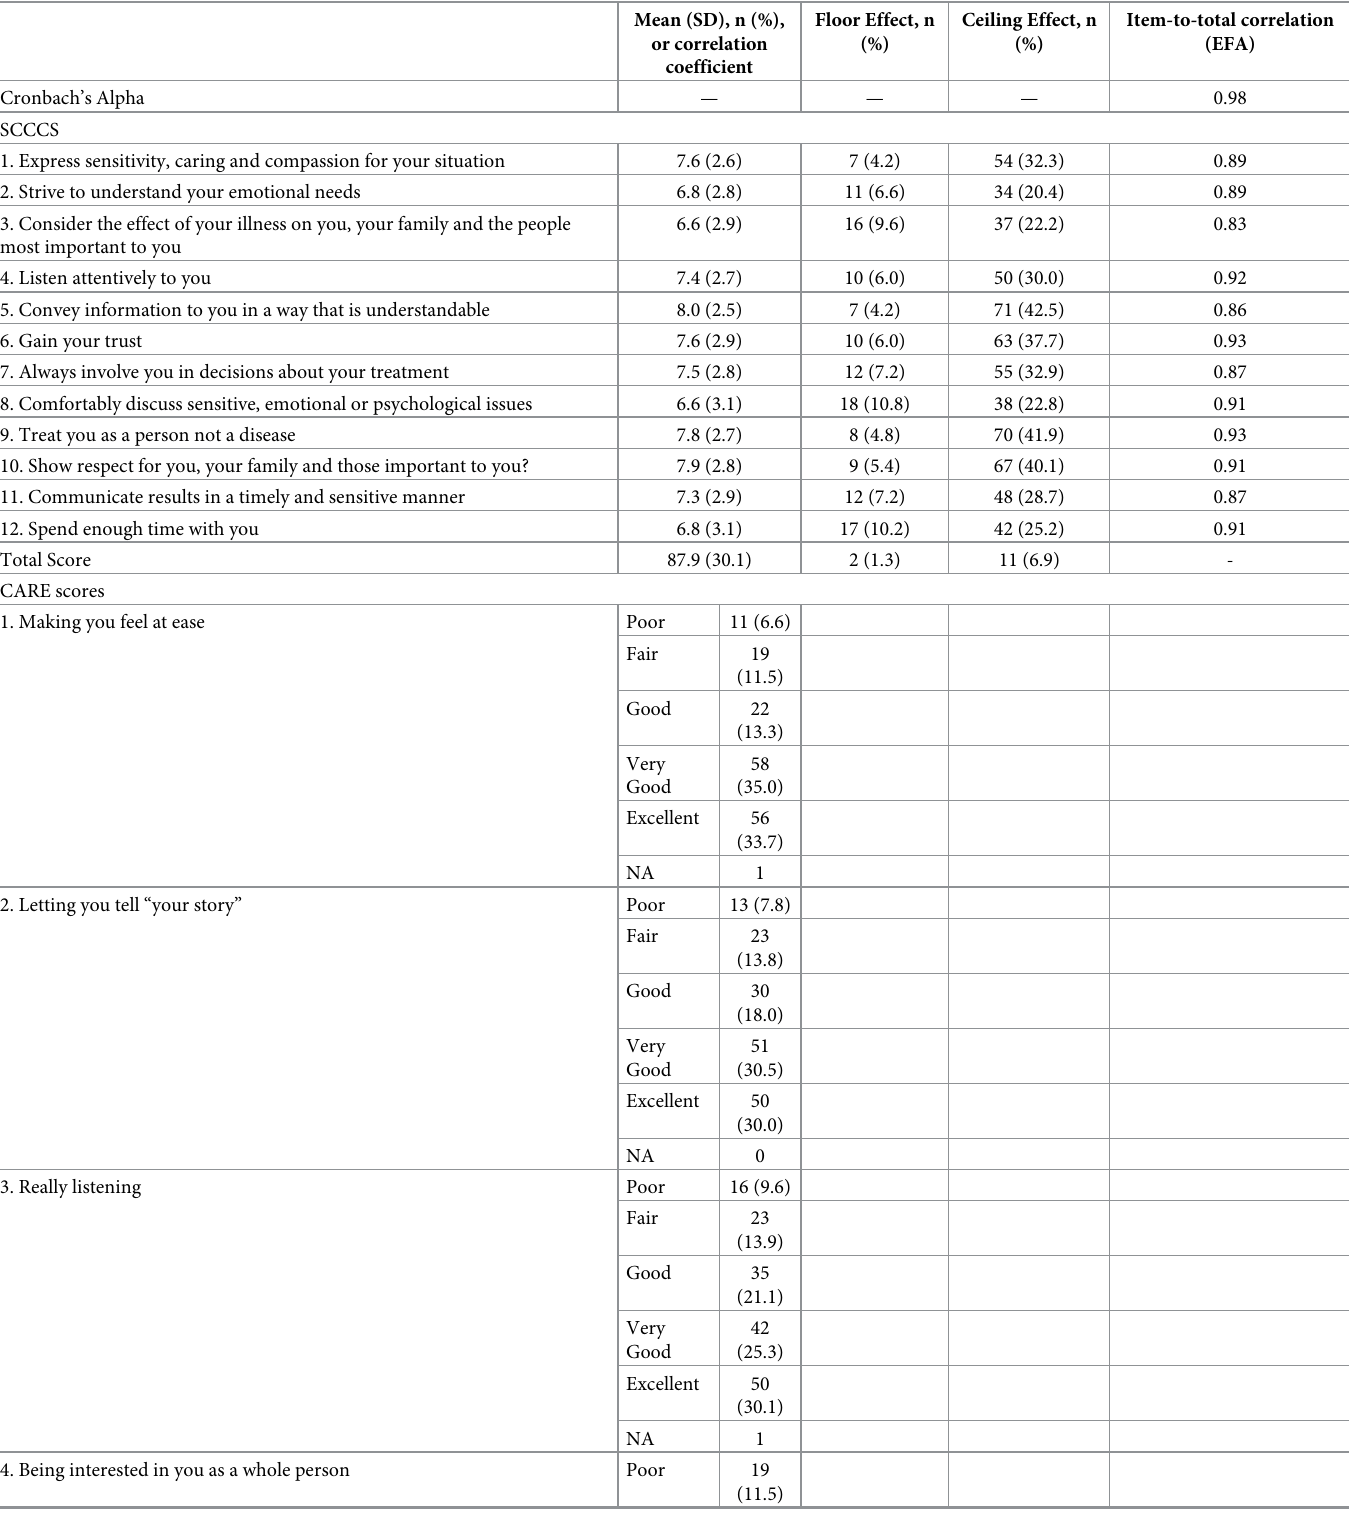
Table 2. Psychometric properties of the SCCCS using classical test